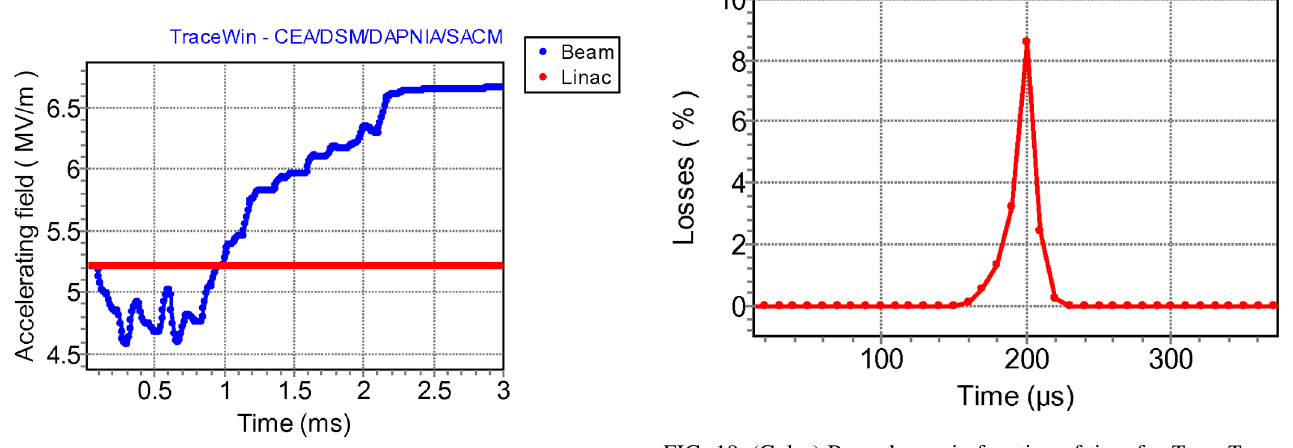
FIG. 19. (Color) Beam losses in function of time for T 200 (cid:4) s